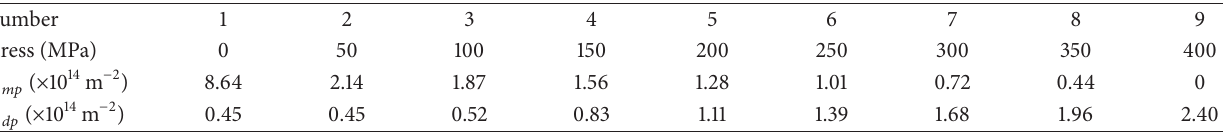
Table 1: Parameters for theoretical models.